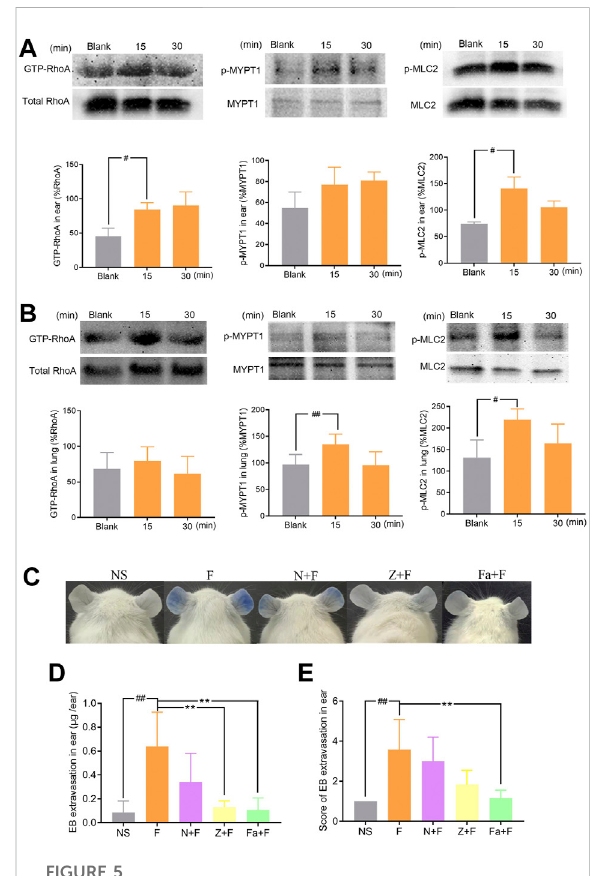
FIGURE 5 The effect ofpenilloic acid on RhoA/ROCK signaling pathway in mice. (A) Western analysis of GTP-RhoA/RhoA, p-MYPT1/ MYPT1 and p-MLC2/MLC2 expression in ears of mice treated with 12 mg/kg penilloic acid for 15 min, 30 min, respectively ( n = 3, per group). (B) Western analysis of GTP-RhoA/RhoA, p-MYPT1/ MYPT1 and p-MLC2/MLC2 expression in lungs of mice treated with 12 mg/kg penilloic acid for 15 min, 30 min, respectively ( n = 4, per group). (C – E) Nimesulide(COX-2inhibitor), zileuton(5-LOXinhibitor) and fasudil (ROCK inhibitor) could reduce vascular leakage reaction induced by penilloic acid. (D) EB extravasation and (E) score of EB staining in the ears ( n = 6). F: 12 mg/kg penilloic acid; N: 20 mg/kg nimesulide;Z:20 mg/kgzileuton;Fa:30 mg/kgfasudil. # p < 0.05 and ## p < 0.01comparedwiththeNSgroup;* p < 0.05comparedwiththe penilloic acid